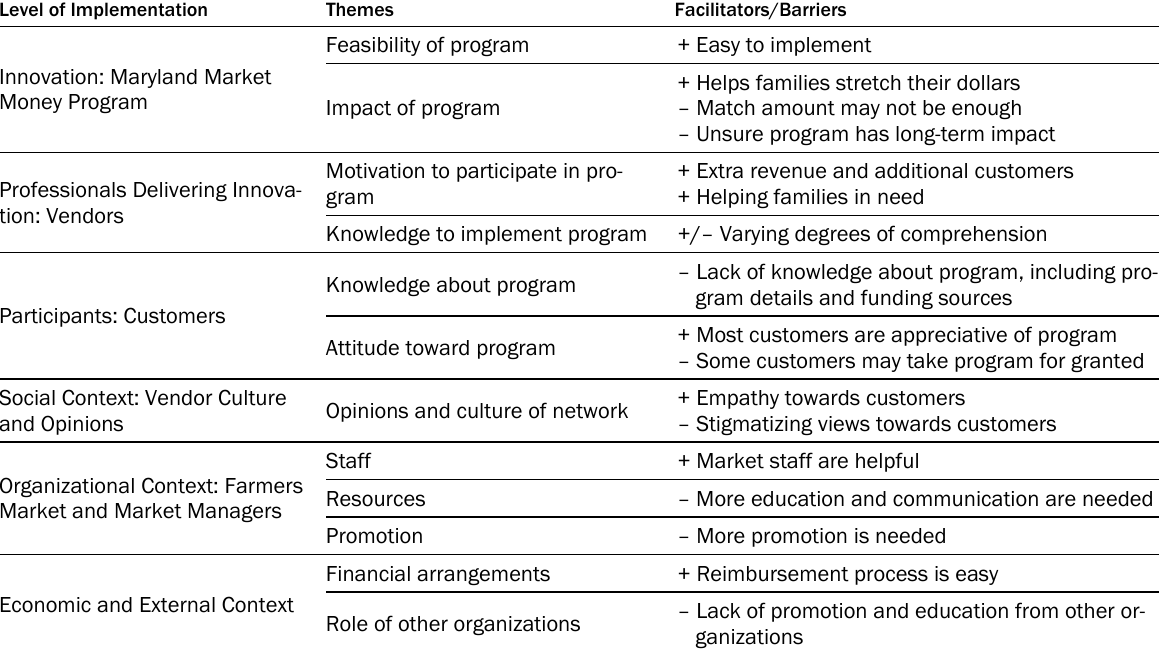
Table 1. Perceived Facilitators and Barriers to Implementation of the Maryland Market Money Program among Vendors ( n =19)